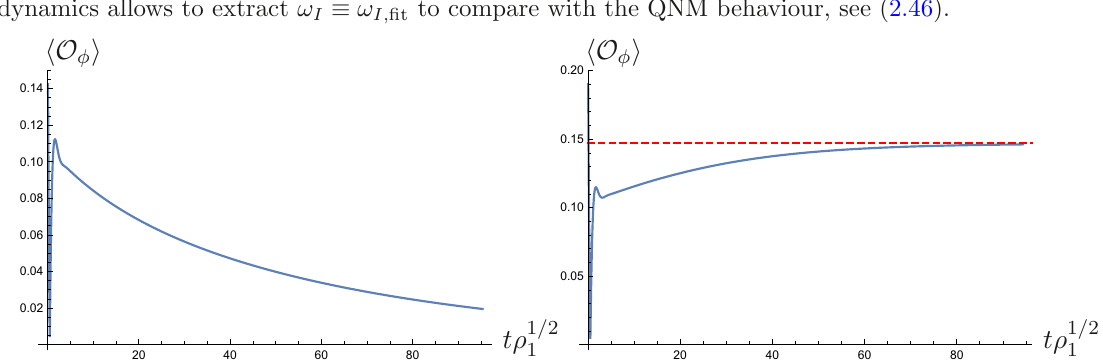
Figure 5 . Same as in figure 4, except for the evolution of dynamics allows to extract ω I